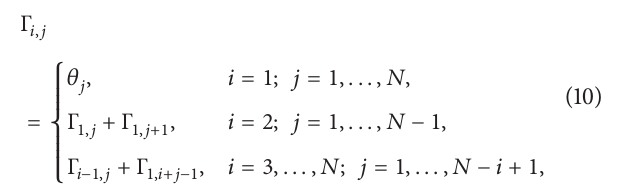
fed back to the radar system where the appropriate waveform is